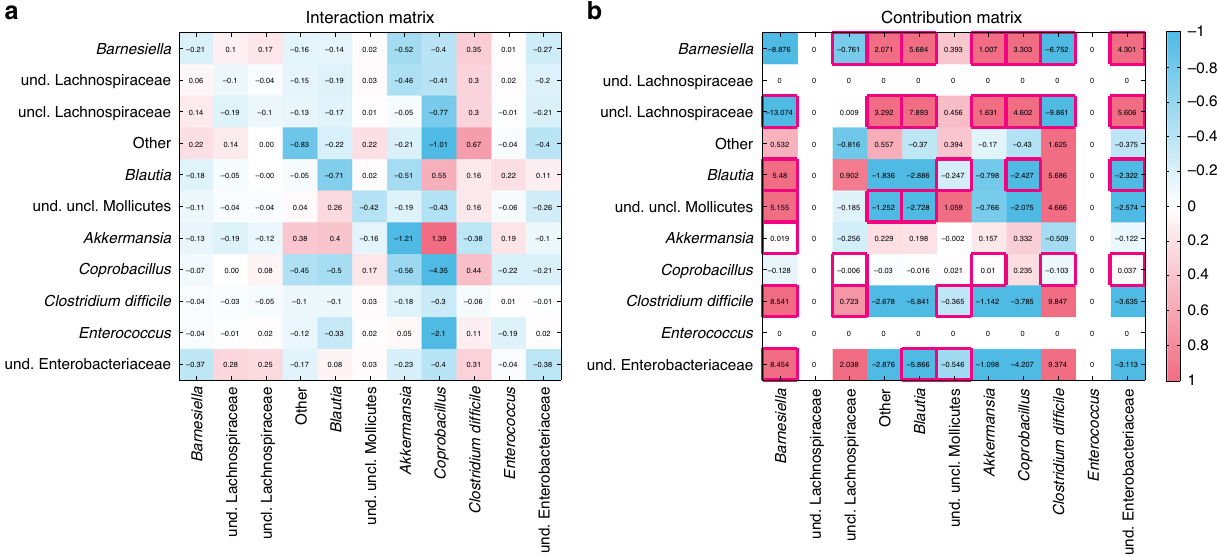
Fig. 7 Interaction matrix and contribution matrix of a real microbial community. a The interaction matrix of an ecological network inferred from mice experiments on antibiotic-mediated CDI 66 . b The contribution matrix of this ecological network. Zero rows and columns indicate two taxa that will go to extinction asymptotically in this community (see Supplementary Fig. 3 for details). The red boxes indicate the counter-intuitive cases of the network effect. For the visualization purpose, the color scale was set from − 1 to 1, and the values < − 1 (or >1) were indicated as the same color of the value − 1 (or 1),